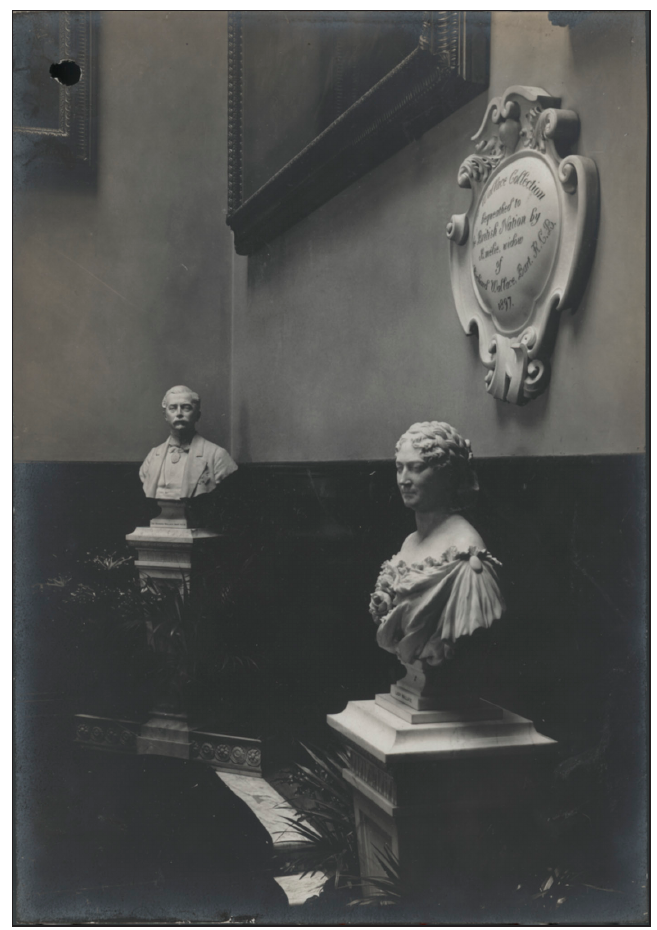
Fig. 11 : View of the busts of Sir Richard and Lady Wallace on the half-landing of the Grand Staircase at Hertford House in the early years of the Wallace Collection. The early eighteenth-century French staircase balustrade (Wallace Collection, F68) was the only work of art mentioned specifically in Lady Wallace’s bequest. She envis- aged the collection moving to a purpose-built location, and the balustrade was to go with it. The Wallace Collection Picture Library. © The Trustees of the Wallace Collection,